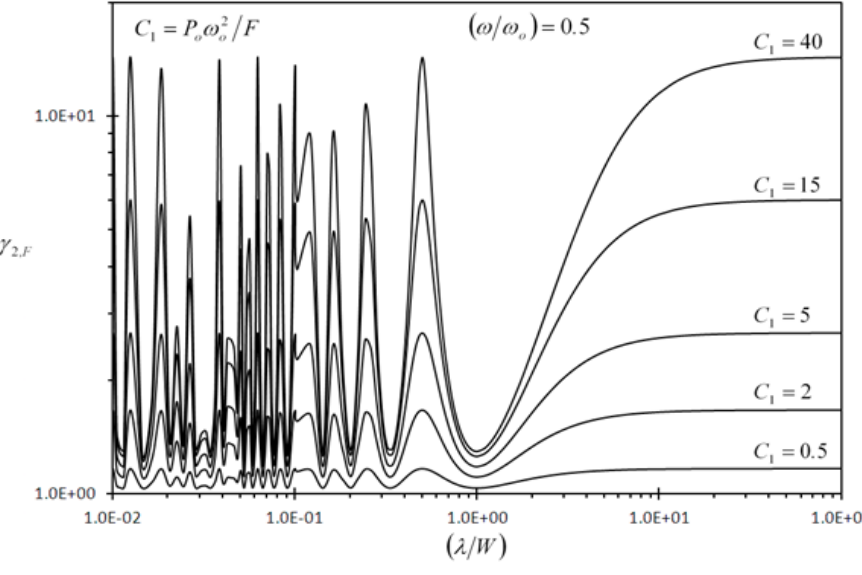
Figure 8. Effects of the dimensionless dynamic disturbance wavelength ( λ / W ) and the first dimensionless dynamic disturbance force amplitude { P enhancement indicator of the rectangular microcantilever with long-slit due to concentrated force loading ( γ 2,F